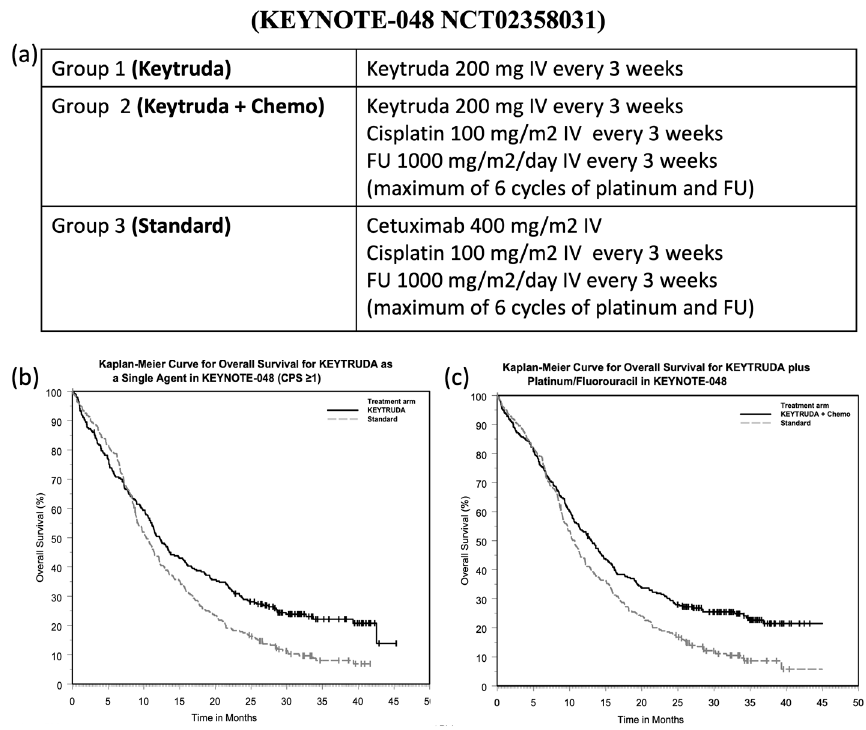
Figure 2. KEYNOTE-048, ( a ) randomized groups and treatments used; ( b ) Keytruda as a single agent and standard (Cetuximab + Cisplatin + 5-Fluorouracil); ( c ) Keytruda + chemo and standard (Cetuximab + Cisplatin + 5-Fluorouracil [37].